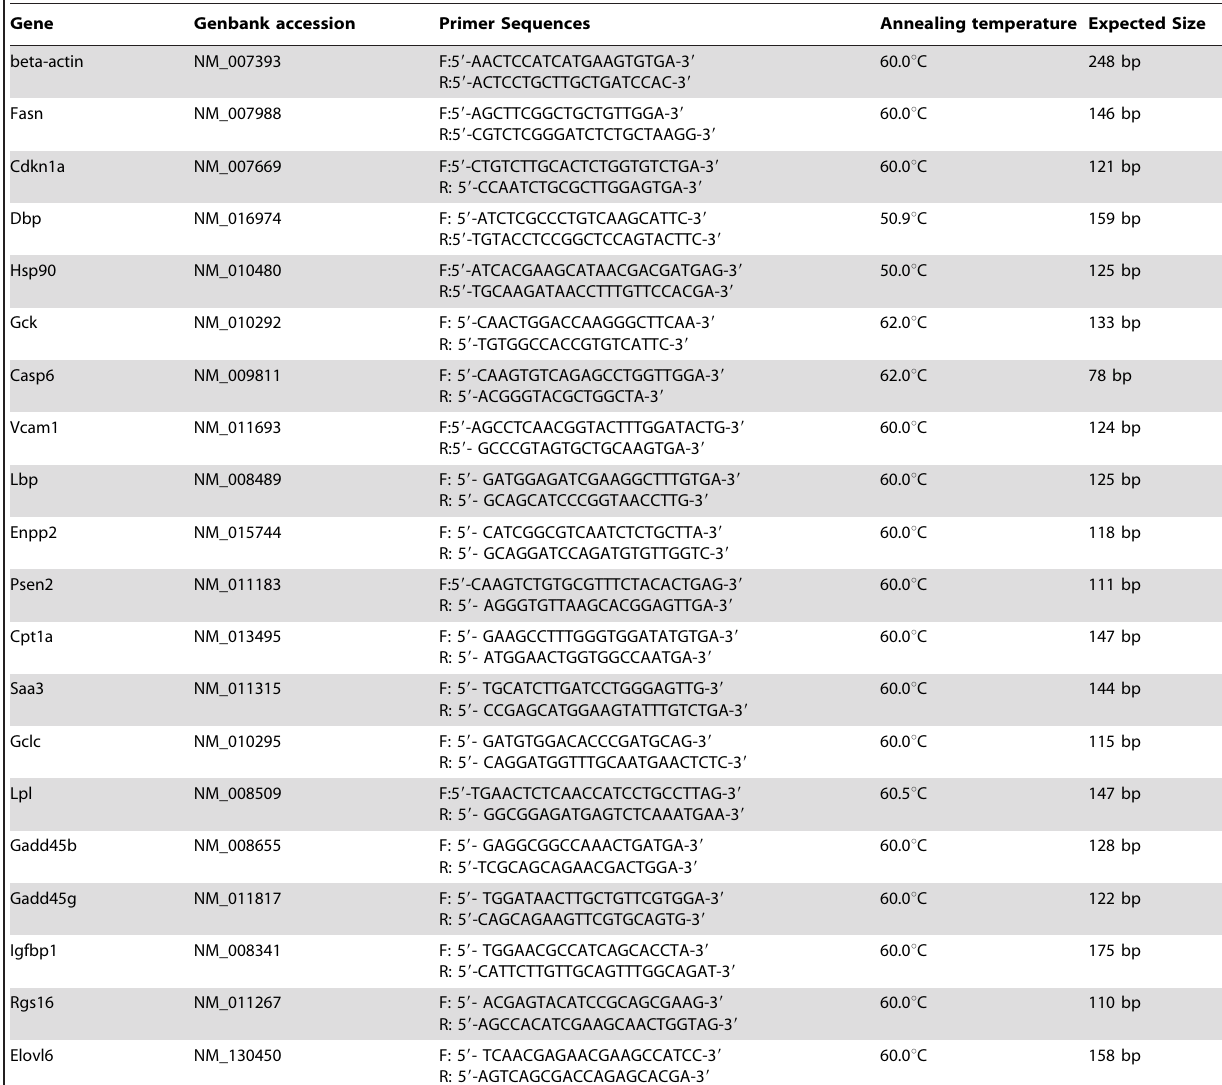
Table 7. Primers and cycling parameters of qRT-PCR verification for microarray data.